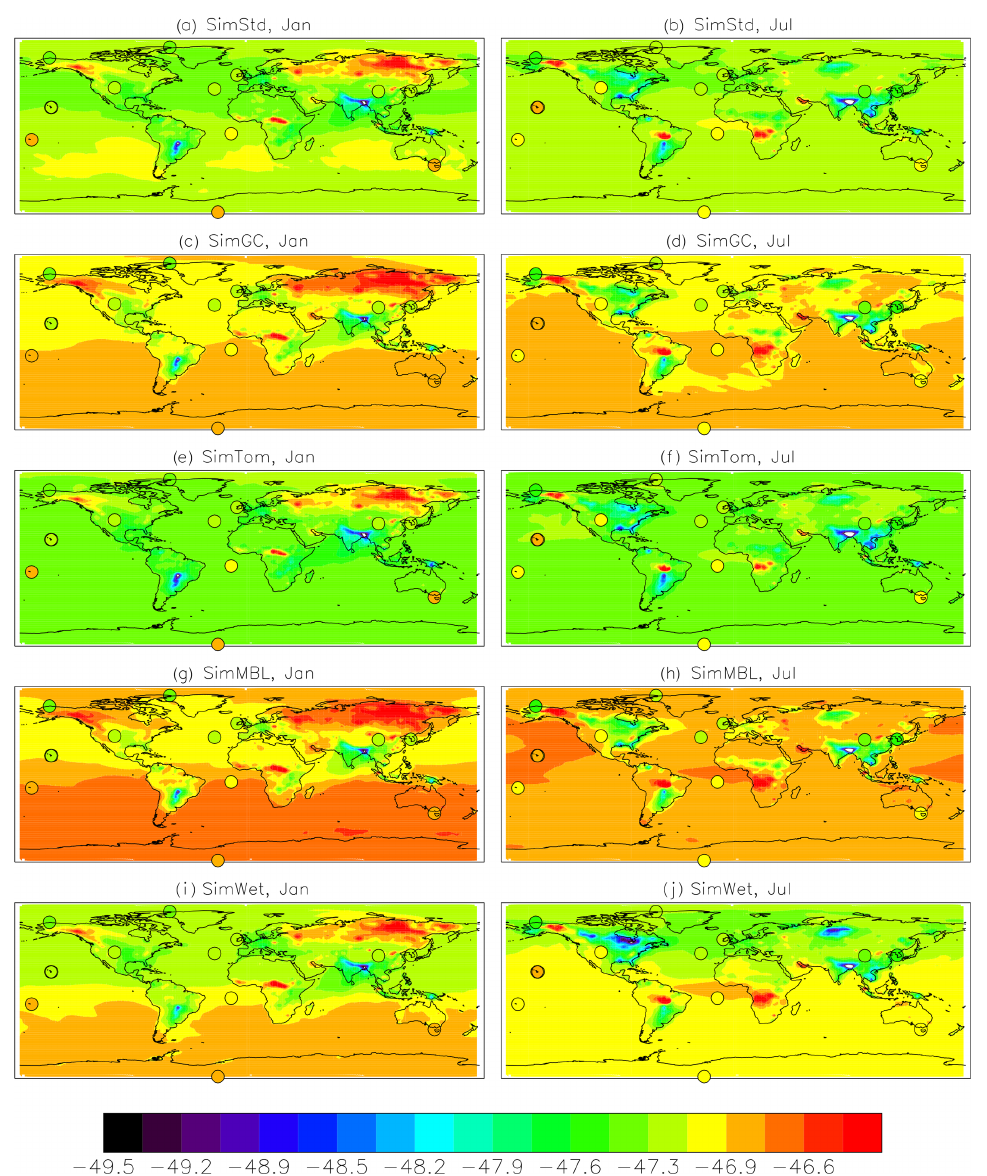
Figure 5. Maps of the simulated surface δ 13 C of CH 4 in per mil for January (left) and July (right) overplotted with observations from the GMD sites (circles). The simulations are (a, b) SimStd, (c, d) SimGC, (e, f) SimTom, (g, h) SimMBL, and (i, j)